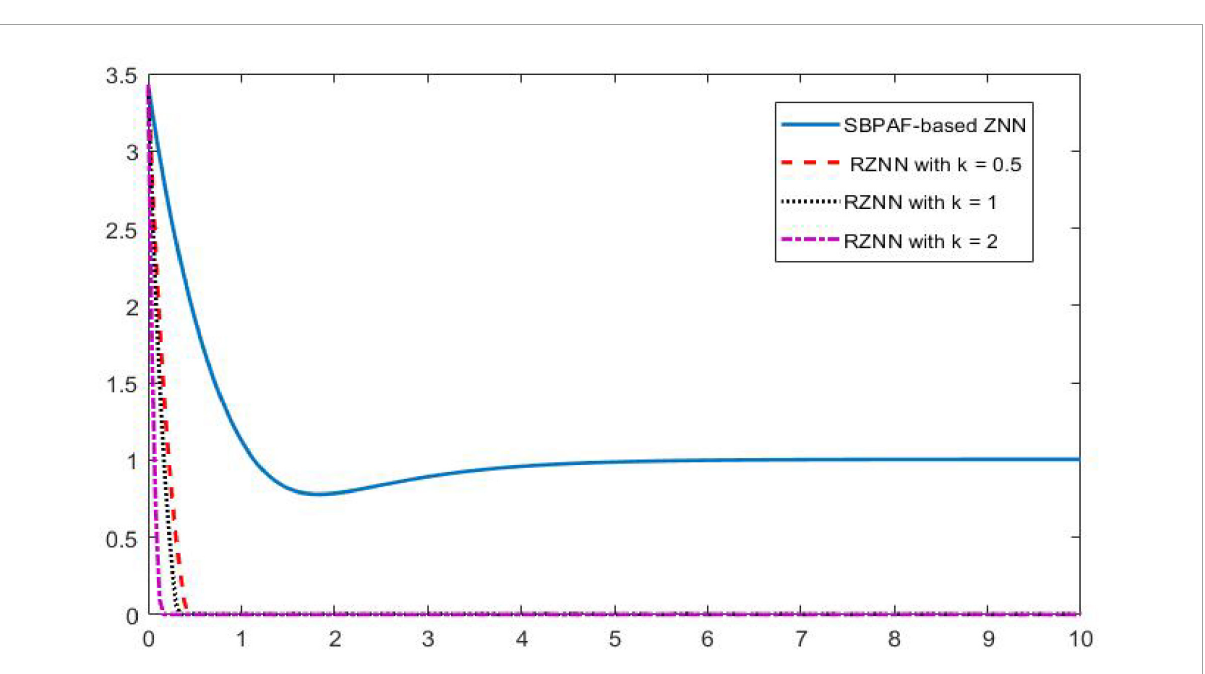
k = 2 for solving DME (5). The corresponding simulation results are presented in Figures 1–5 , and solid blue curves are state solutions of DME (5) obtained by neural network models, and red dotted curves are theoretical solutions of DME